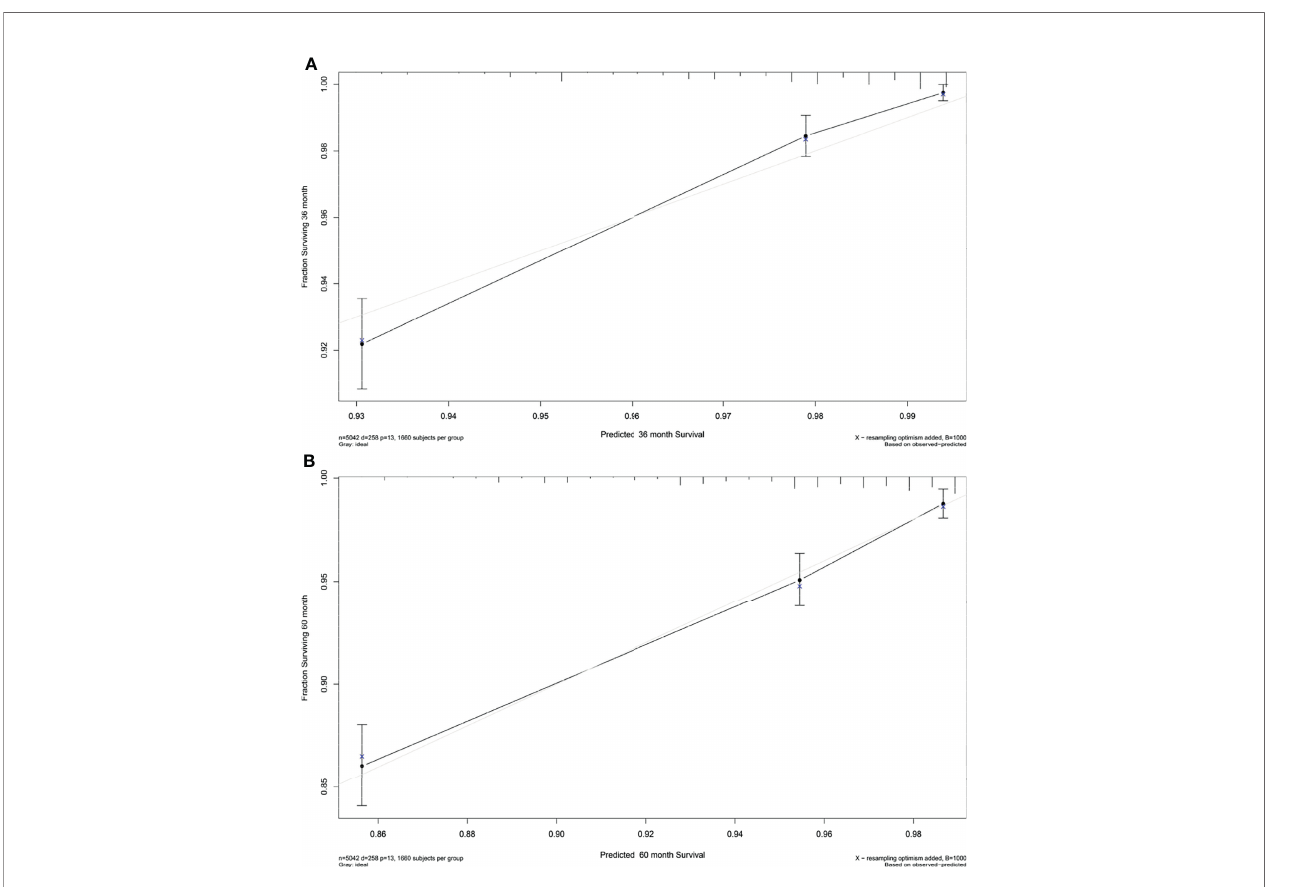
FIGURE 5 | Calibration plot for the prediction of (A) 3-year CSS and (B) 5-Year CSS in young women with early-stage breast cancer. The solid black line represented the performance of the nomogram, of which the closer fi t to the gray line represents the better prediction of the nomogram we constructed. CSS, cancer-speci fi c